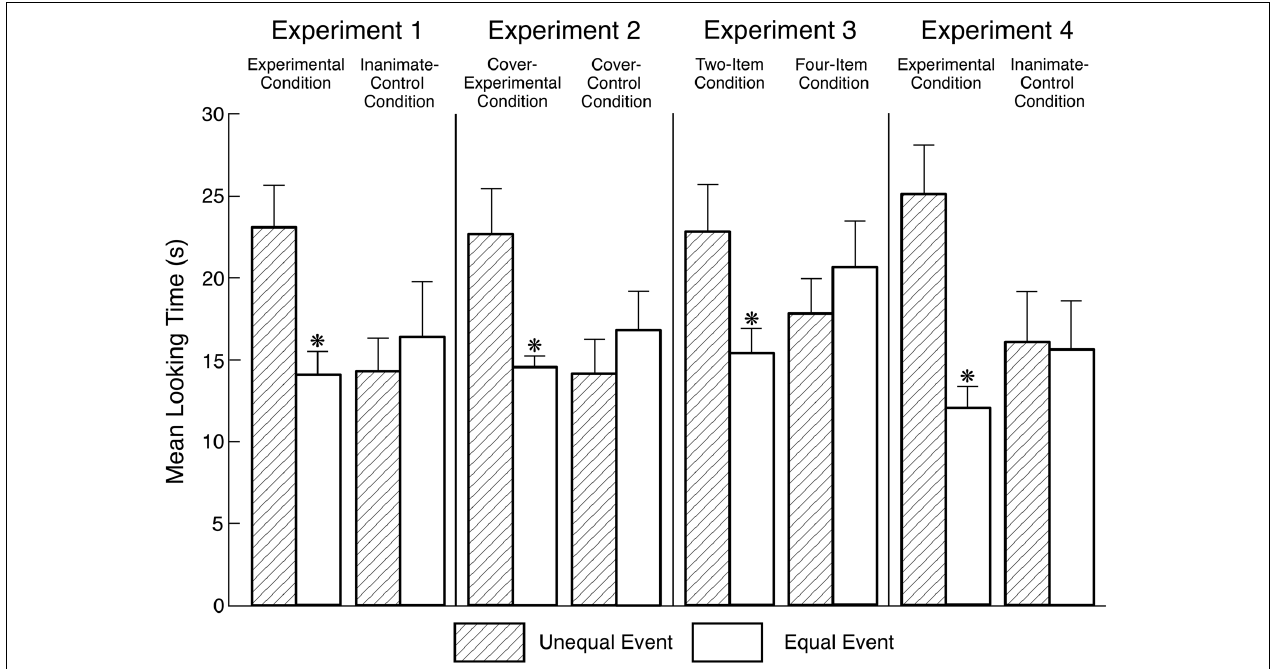
FIGURE 2 | Mean looking times at the unequal and equal events during the final phase of the test trial in the various conditions of Experiments 1–4. The errors bars represent standard errors, and each asterisk denotes a significant difference between the two events within a condition ( p < 0.05 or